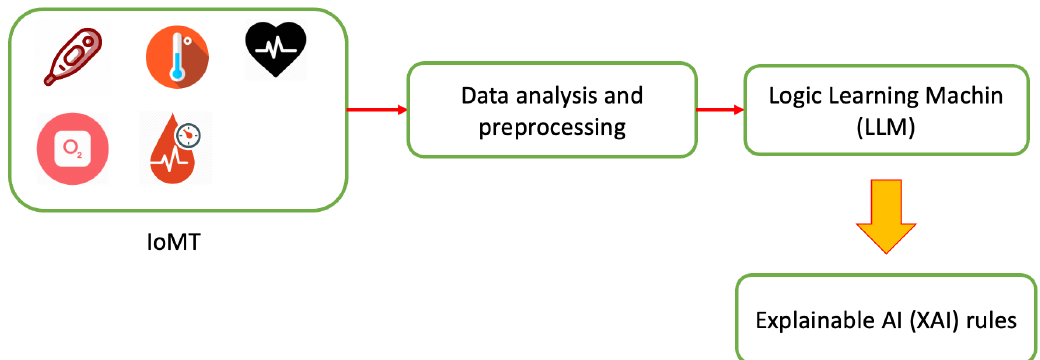
Figure 1. Pneulytics framework